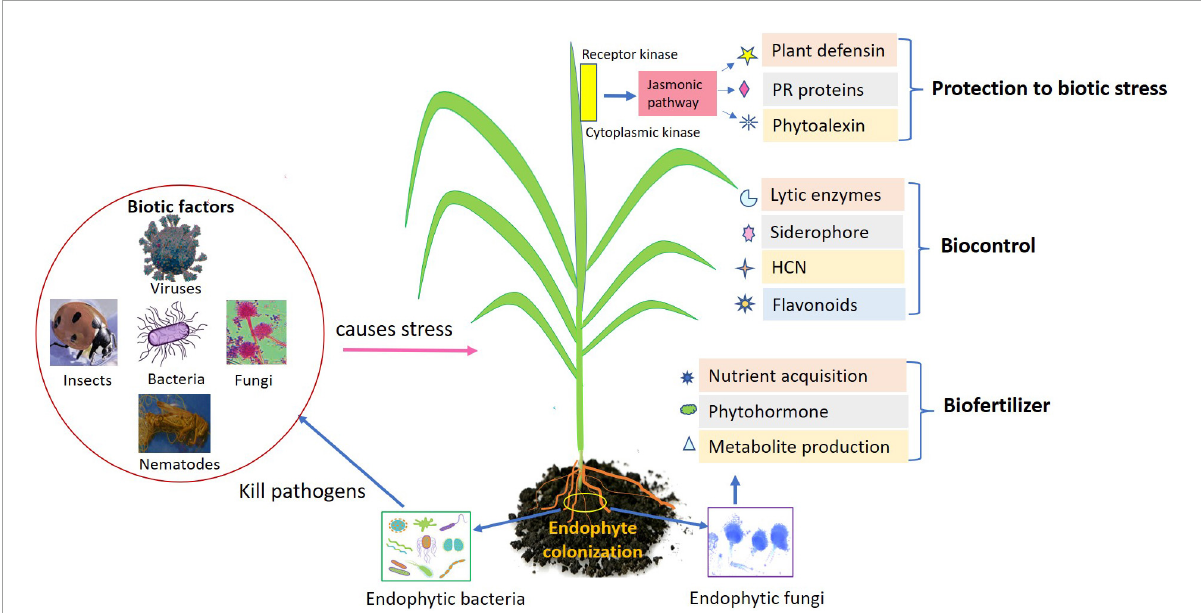
FIGURE1 Role of endophytes as biofertilizers, biocontrol, and biotic stress management in agricultural